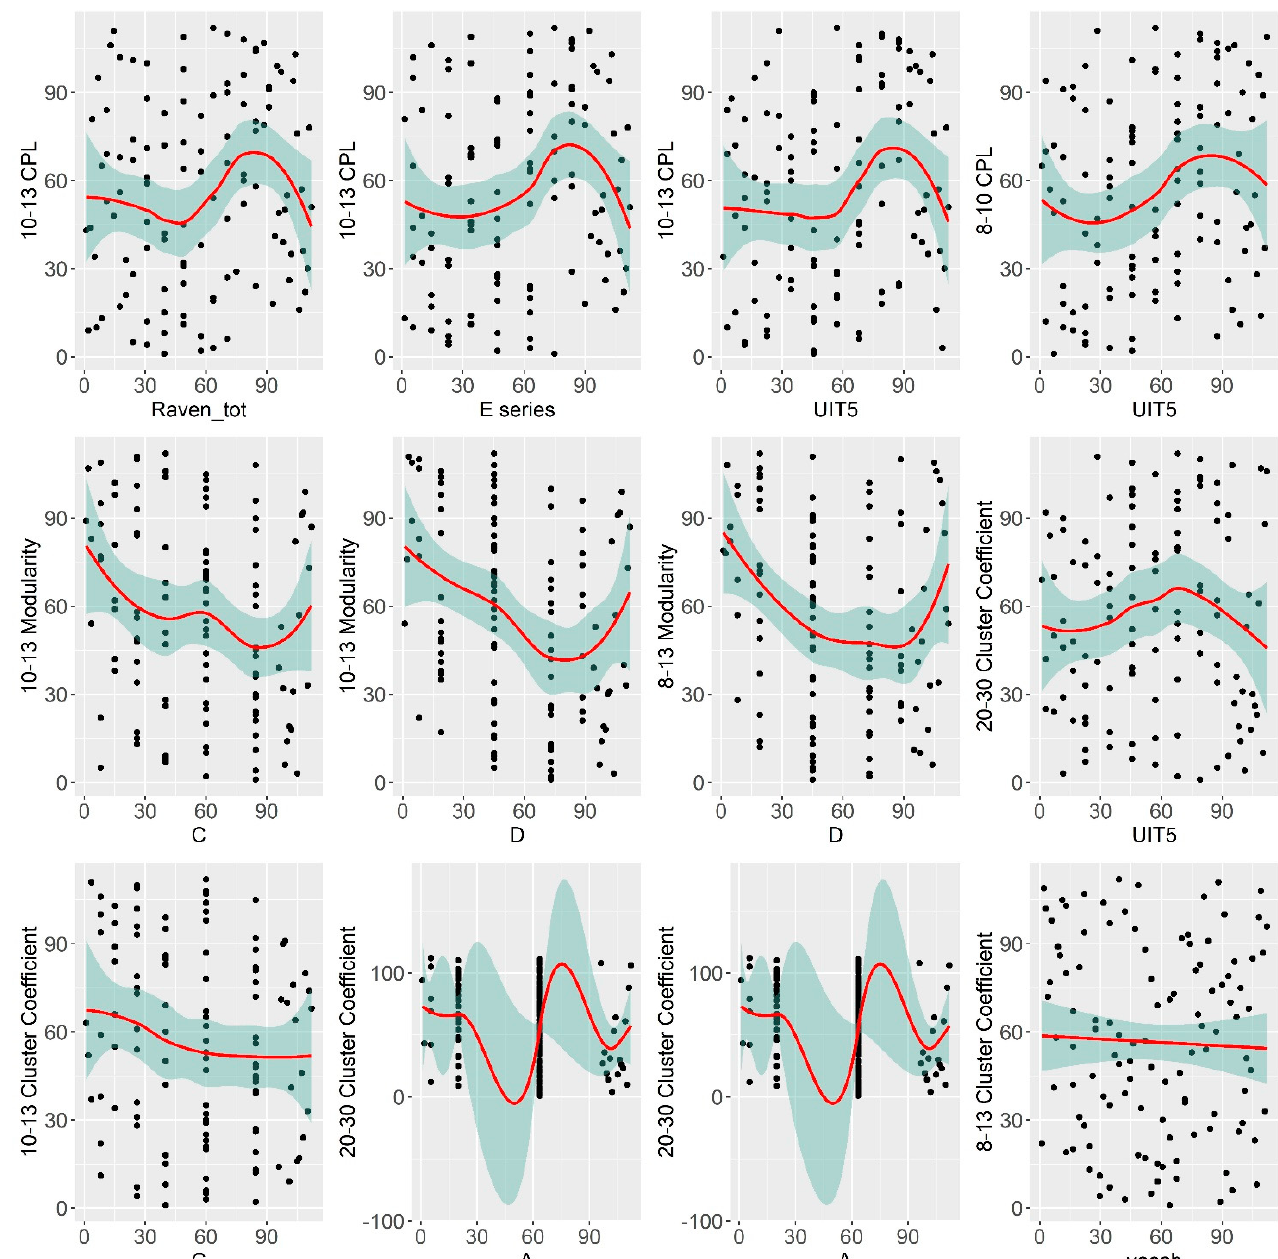
Figure 5. The scatterplots for the significant correlations. Correlations of significance level p < 0.05 are marked in color. CPL—Characteristic Path Length; UIT1—“Awareness” verbal subtest, UIT5—“Conclusion” subtest of the Universal Intellectual Test, vocab—“MyVocab” test. The ranks of the values were taken instead of the original value.